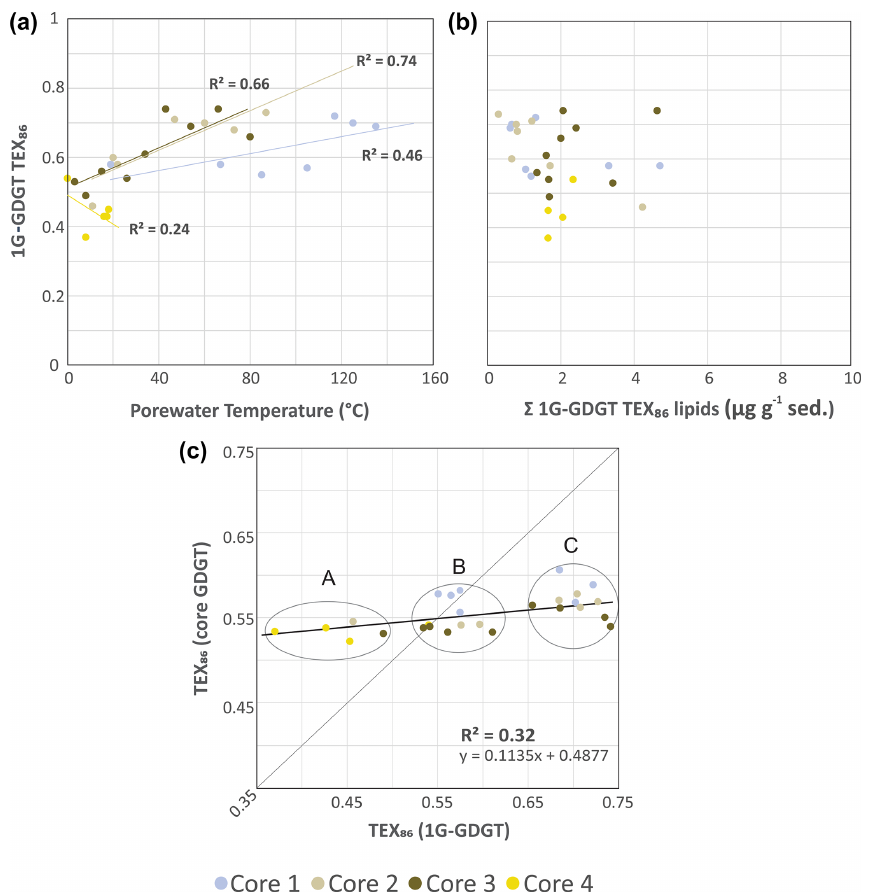
Figure 5. Cross plots of 1G-iGDGT IPL TEX 86 versus (a) porewater temperatures and (b) the concentration of 1G-iGDGTs in the sediments. (c) TEX 86 proxy for core GDGTs versus 1G-GDGTs. Clusters A – C may represent different archeal communities that are providing varying inputs of iGDGT to the core GDGT lipid pool. The dotted trend line is the partial least-square regression of the complete core lipid TEX 86 data set. The solid line marks the 1 : 1 CL-to-IPL proxy correspondence indicating both allochthonous and autochthonous sources contribute equally to the core GDGT lipid